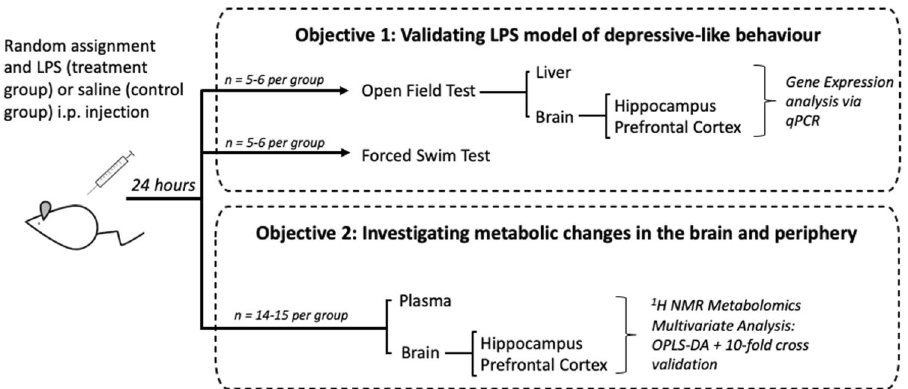
Figure 1. Summary of study design. Mice were treated with lipopolysaccharide (LPS) or saline to fulfil the study objectives of (A) validating the LPS model of depressive-like behaviour with behavioural and mRNA analysis and (B) studying peripheral and central metabolic changes with 1 H NMR metabolomics. Original artwork was provided by Dr Biyan Zhang, A*STAR,